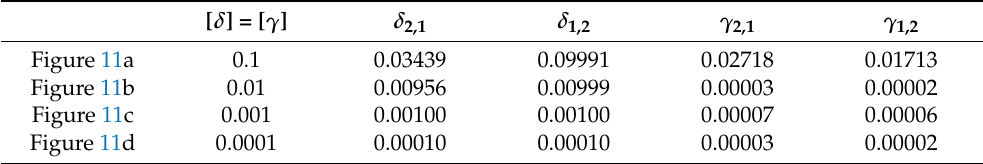
Table 4. Output and input coupling indices of the four design results shown in Figure 11.